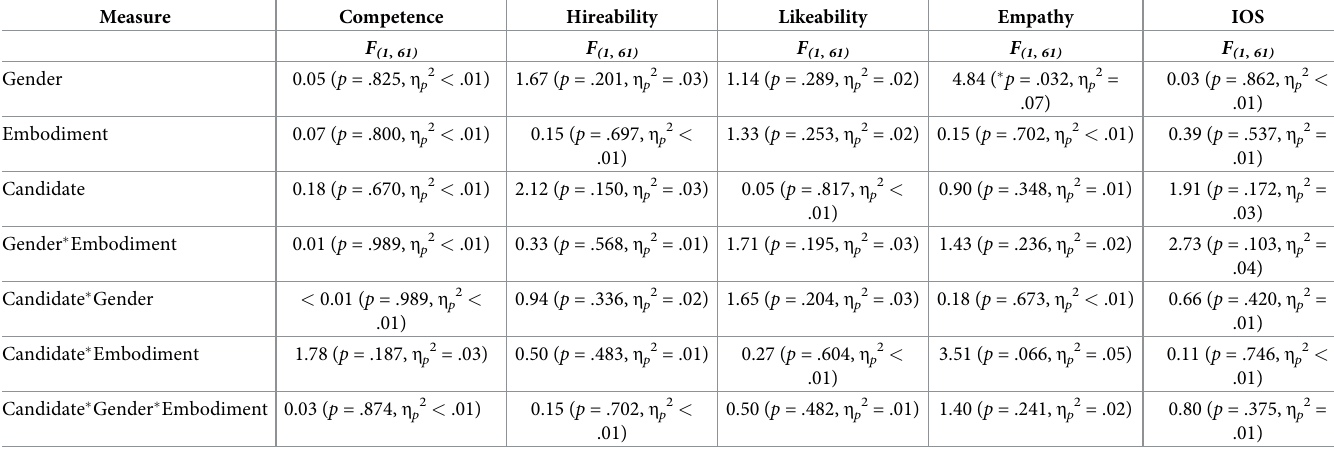
Table 4. Mixed ANOVA models for candidate ratings following online perspective taking.